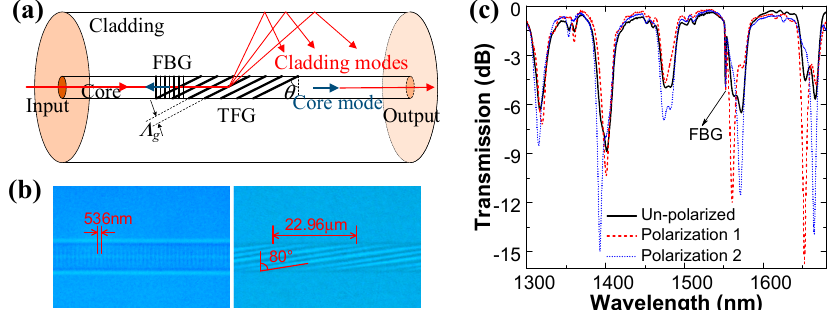
Figure 1. ( a ) Schematic model of the hybrid grating with an FBG and an excessively tilted fiber grating (Ex-TFG) in the reduced-diameter fiber (RDF); ( b ) optical microscopic images of the FBG and Ex-TFG fringes, and ( c ) transmission spectrum of the hybrid grating.